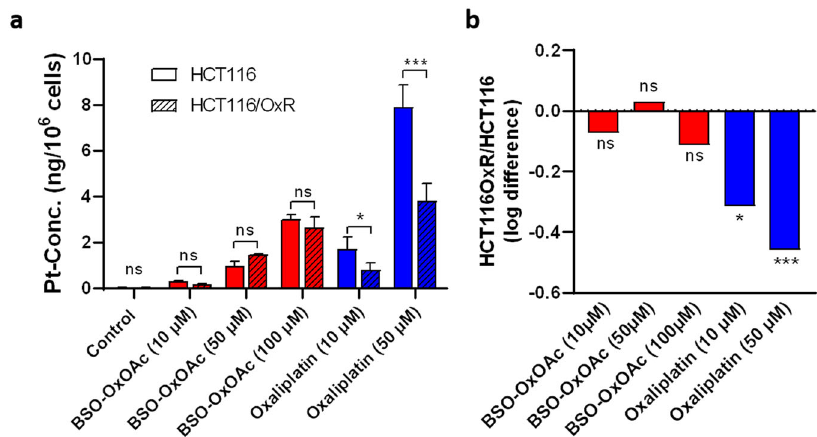
Fig. 5 Cellular uptake of BSO-OxOAc as compared to free oxaliplatin and impact of acquired oxaliplatin resistance. a Parental HCT116 and oxaliplatin- resistant HCT116/OxR cells were exposed to the indicated concentrations of BSO-OxOAc and oxaliplatin for 3 h and cellular uptake quanti fi ed by ICP-MS. Data are depicted as mean ± SD. b Log-fold difference in the platinum accumulation between parental HCT116 and HCT116/OxR calculated from the data shown in ( a ). Statistical signi fi cance was tested using one-way ANOVA. * p < 0.05; *** p <